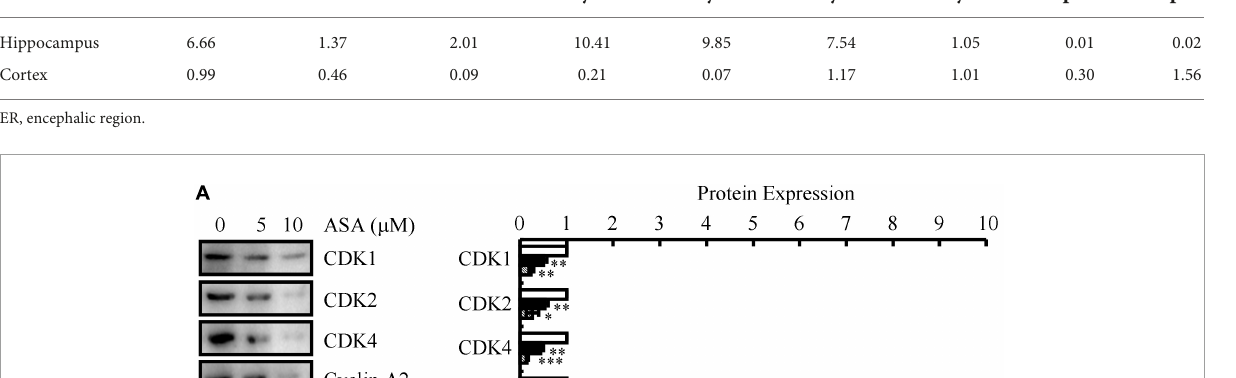
TABLE 5 The expression of cell cycle-associated genes in A β o-injected (i.c.v) mice. Genes ER